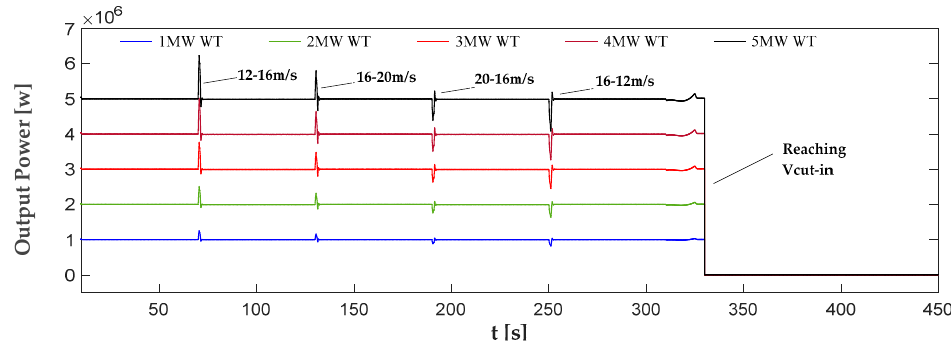
Figure 10. Active power output of WT with five installed capacity of 1–5 MW under five different wind fluctuations.